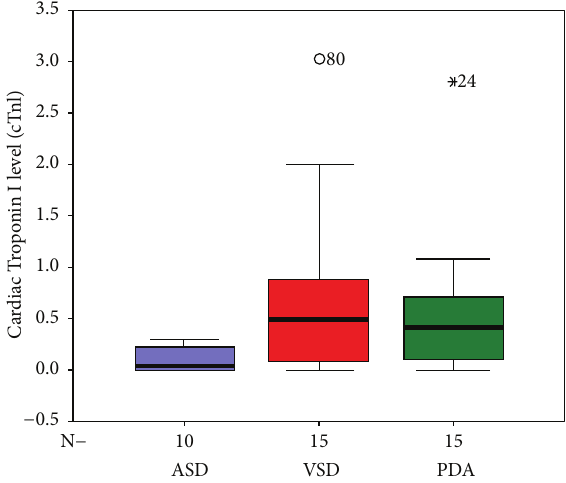
Table 4: Cardiac Troponin I levels in study population.